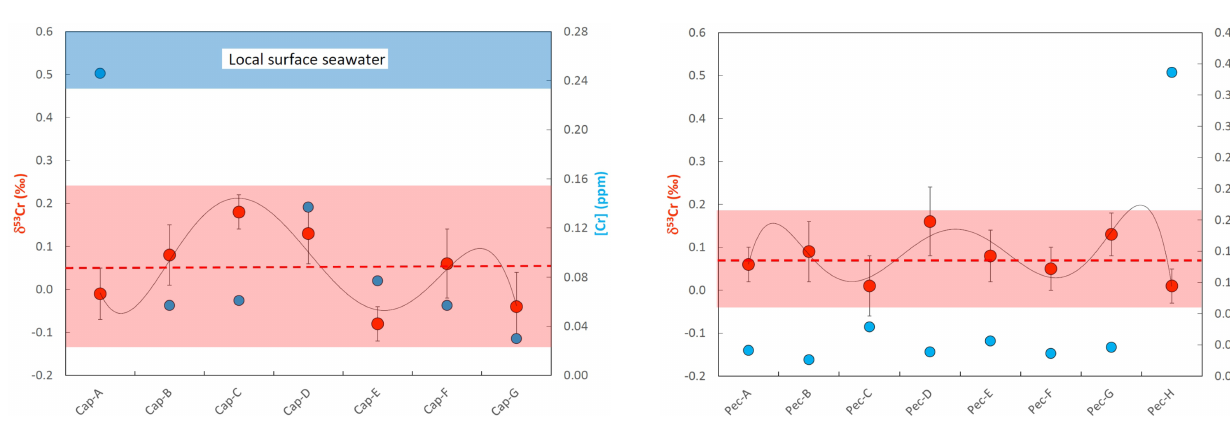
Figure 6. Plot showing the chromium concentrations ([Cr]; blue filled symbols) and chromium isotope compositions ( δ 53 Cr; red filled symbols) of samples along a growth transect of a Placuna placenta sample (depicted in Fig. 2) from Kakinada Bay. Sample Cap-A is characterized by an elevated [Cr] which is potentially due to an elevated organic content in the initial growth zone comprising the apex of the shell. The sinusoidal distribution of δ 53 Cr values along the transect potentially reflects seasonal changes in ambient surface seawater. For details refer to the text.